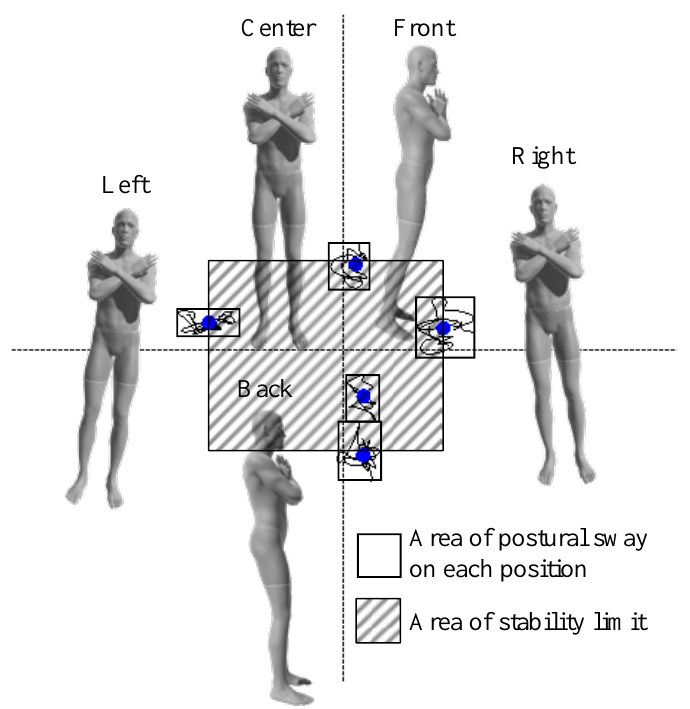
Figure 3. The IPS was determined for all participants. The center of pressure sway, for 10 s, was measured for each participant in the center and in different postures including tilted front, back, right, and left maximally. The gray area indicates the area of postural sway on each position. The shaded area indicates the area of stability limit. IPS: index of postural stability.